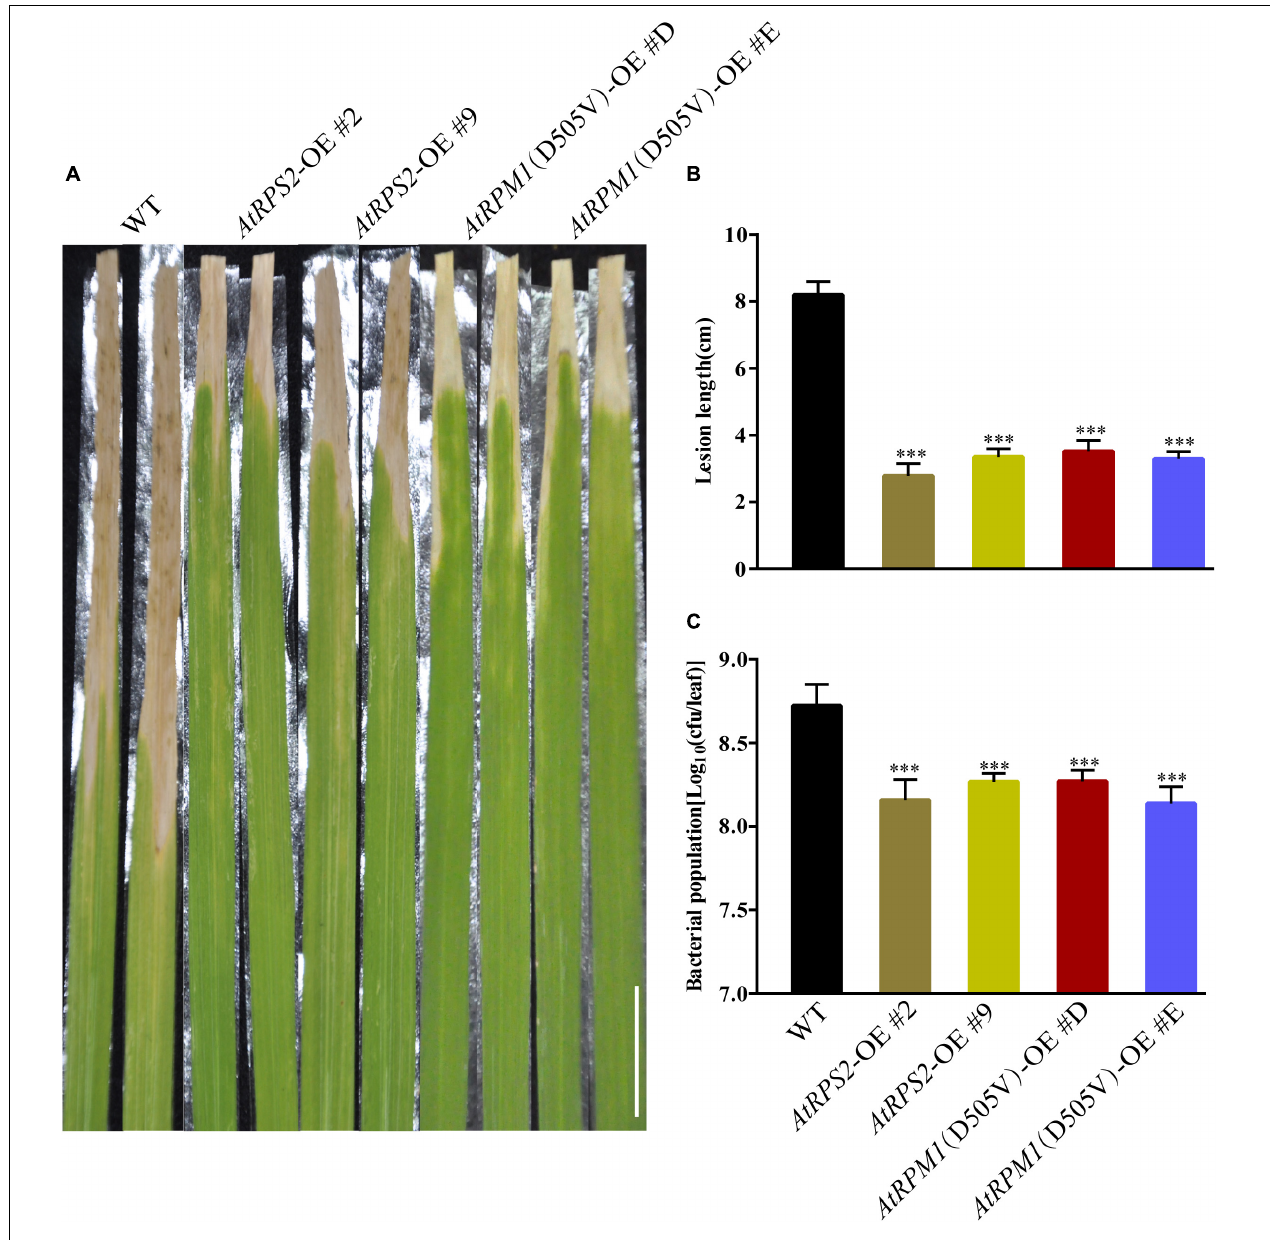
FIGURE 7 | AtRPS2 and AtRPM1 ( D505V ) Confer Resistance to Bacterial Pathogen Xoo in Transgenic Plants. (A) Representative disease phenotypes on leaves of the AtRPS2 , AtRPM1 ( D505V ) transgenic plants and Nipponbare plants at 14 dpi with Xoo strain PXO99. Scale bars = 2 cm. (B,C) Lesion lengths and bacterial growth in the inoculated leaves of the transgenic plants and Nipponbare at 14 dpi. Data are shown as means ± SD ( n = 15). Asterisks denote significant differences (one way ANOVA, ∗∗∗ P < 0.001). Similar results were obtained in three independent